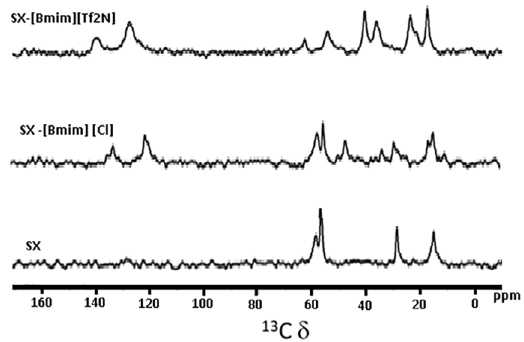
Figure 2. 13 C MAS spectra for silica xerogels.